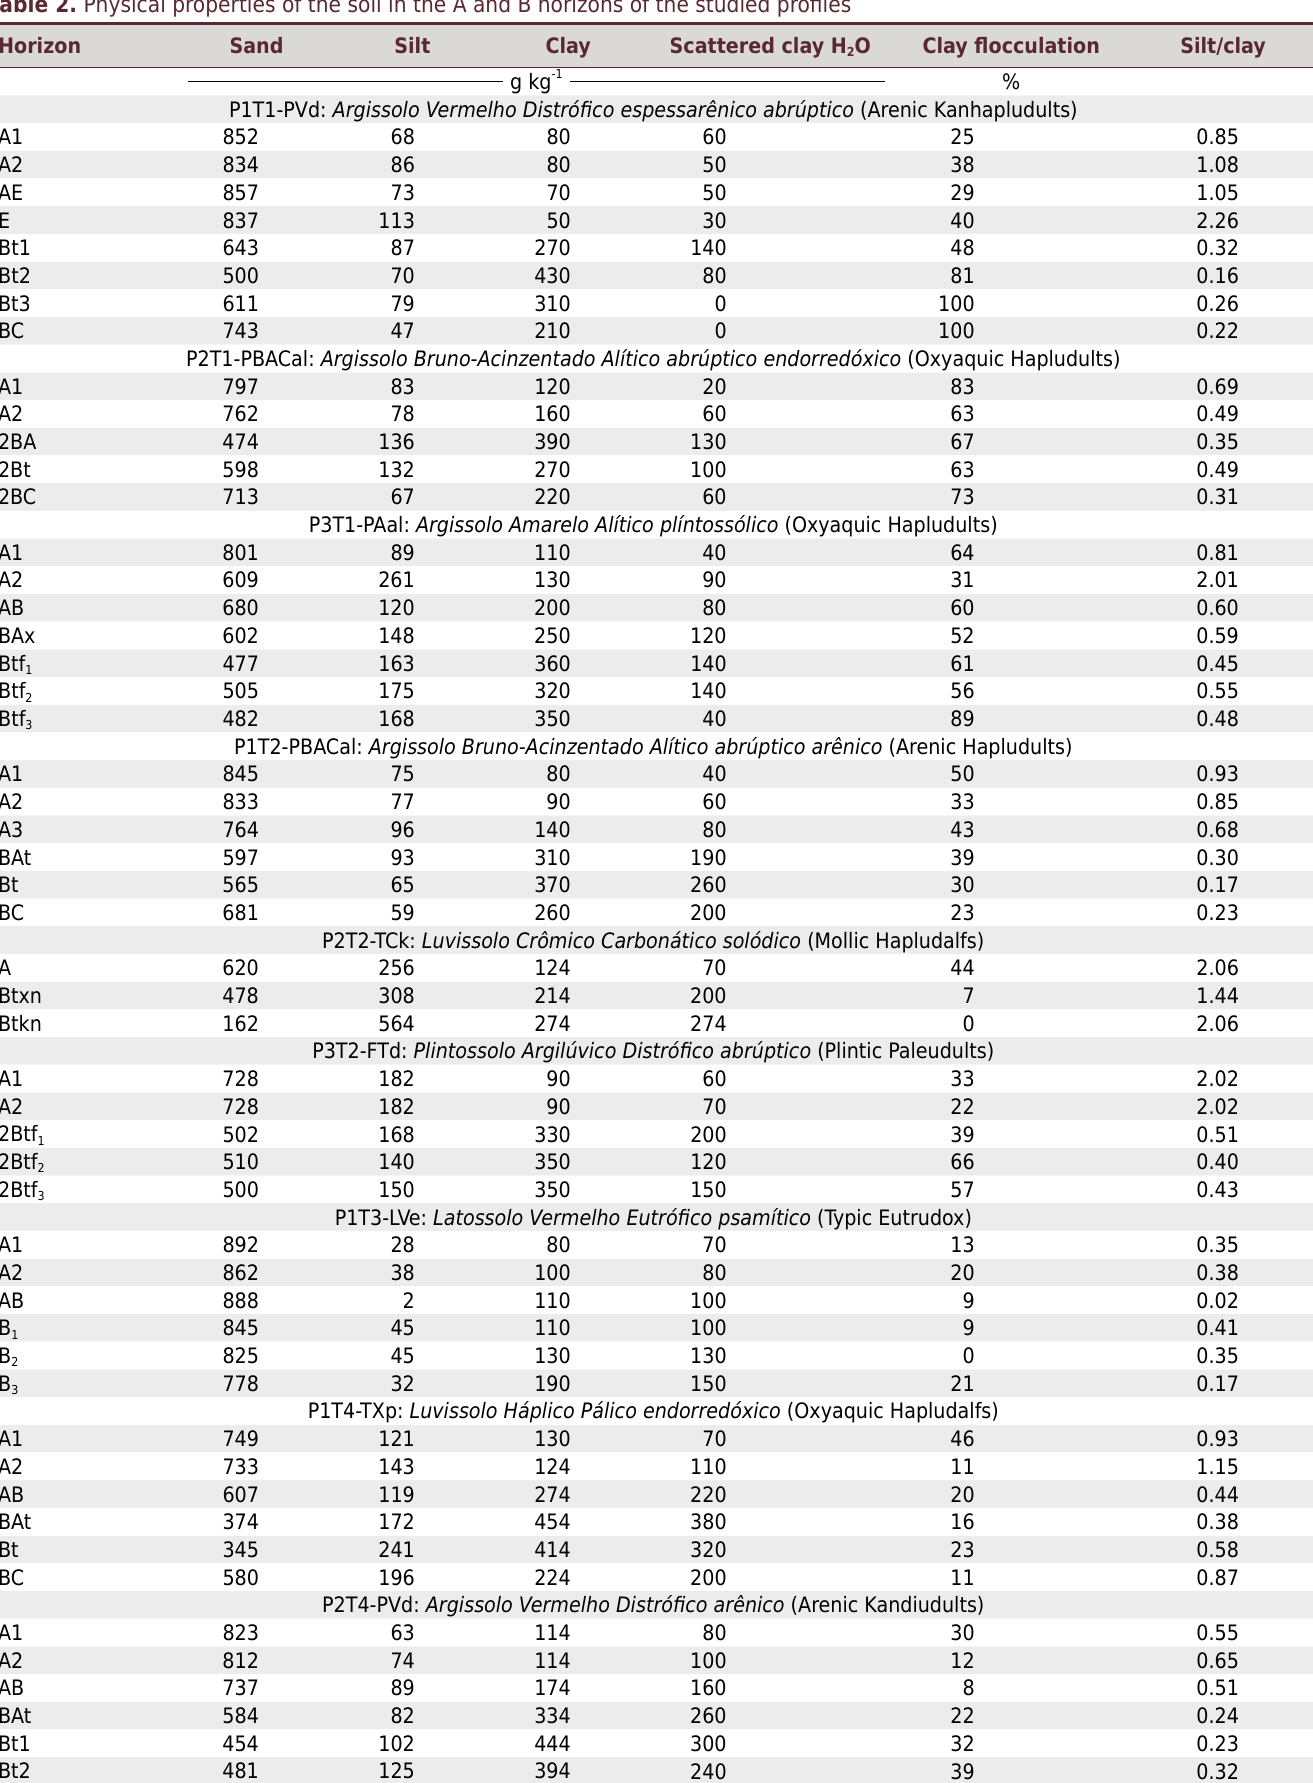
Table 2. Physical properties of the soil in the A and B horizons of the studied profiles Horizon Sand Silt Clay Scattered clay H 2